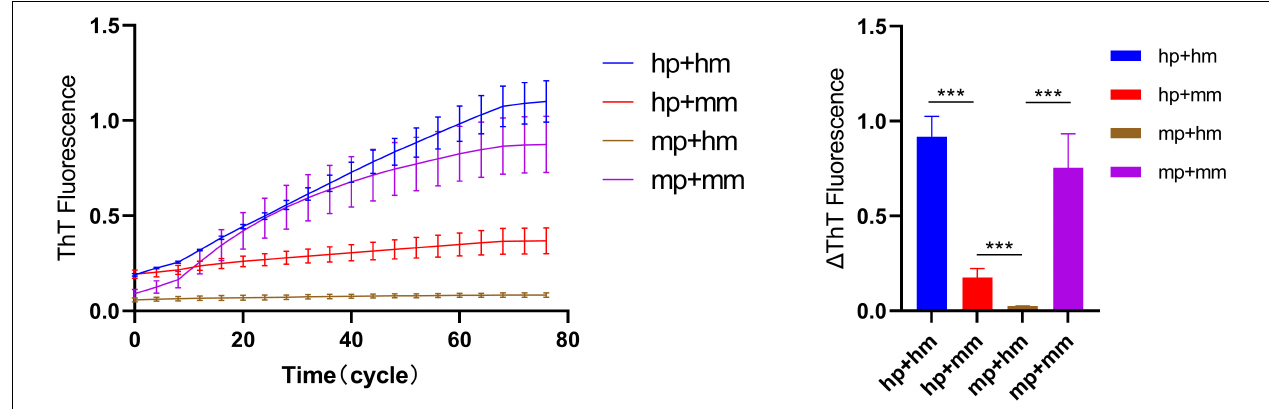
FIGURE 6 | Quiescent incubation curve for heterogeneous amplification of human and mouse α -synuclein. The quiescent incubation curve for heterologous amplification, left. The concentration of human and mouse α -synuclein fibril seeds is 0.1 mg/ml and the concentration of human and mouse α -synuclein monomers is 1 mg/ml. Corresponding (cid:49) ThT fluorescence change value, right. All data are expressed in mean ± SD. *** P <